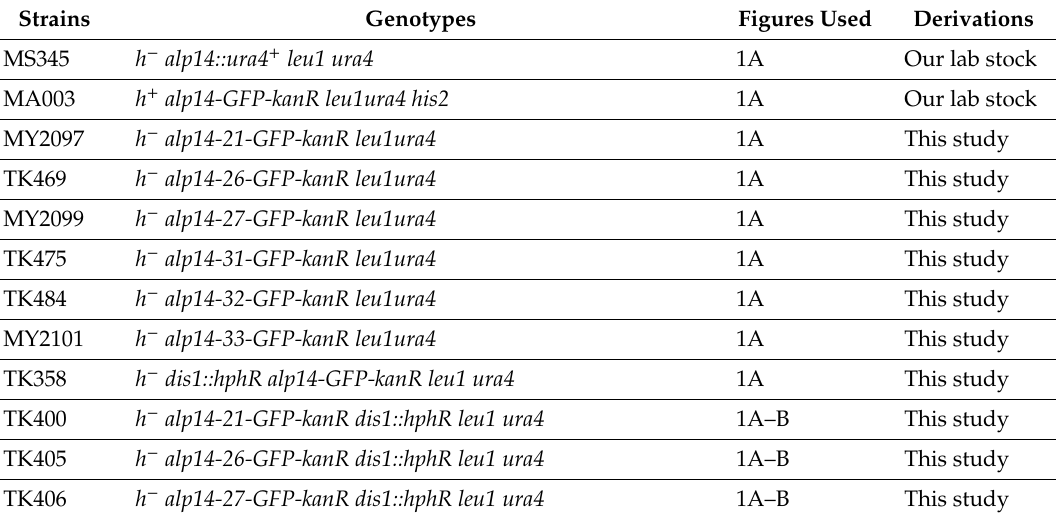
Table 1. Fission yeast strains used in this